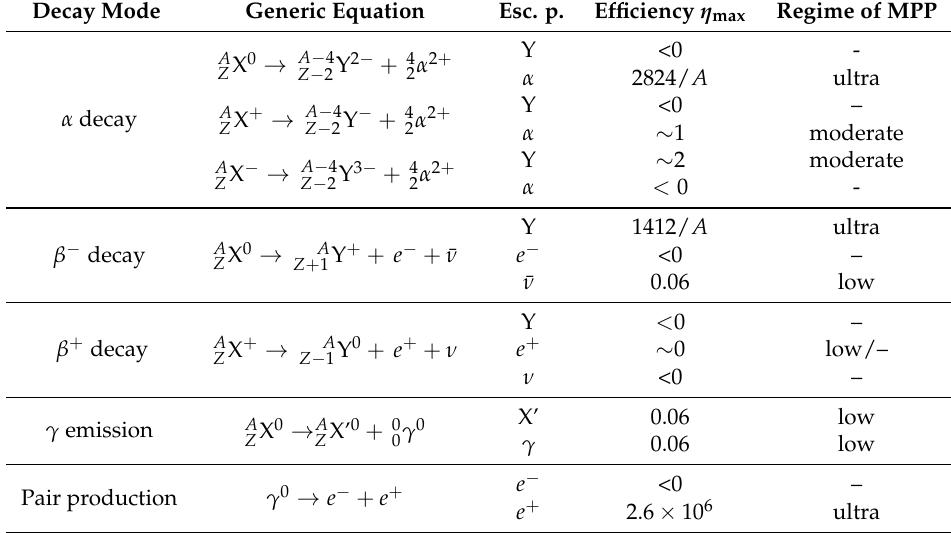
Table 2. Maximum efficiency of magnetic Penrose process and corresponding energy extraction regime for some typical radioactive decay modes in the vicinity of a black hole of mass 10 M (cid:12) with the spin parameter a = 0.8 M . Magnetic field is aligned along the rotation axis and has the strength 10 4 G. Initial energy of decaying particle is taken to be of order of its rest mass, m X c 2 . In the case of the pair production, the energy of photon is taken to be E γ = 2 m e c 2 with recoil term neglected for simplicity. Decay Mode Generic Equation Esc.